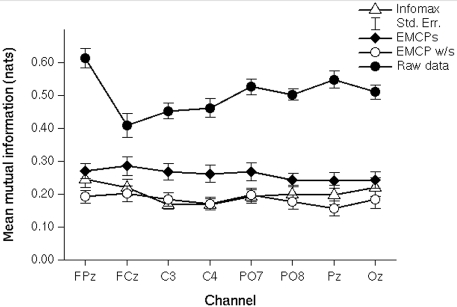
Real data: Mean mutual information of corrected EEG-channels and uncorrected vertical EOG.Mutual information (1 nat≈.44·1/(log 2) bits) is highest for uncorrected data, lower for EMCPs, and lowest for Infomax and EMCP w/s corrected data. Infomax = extended infomax.